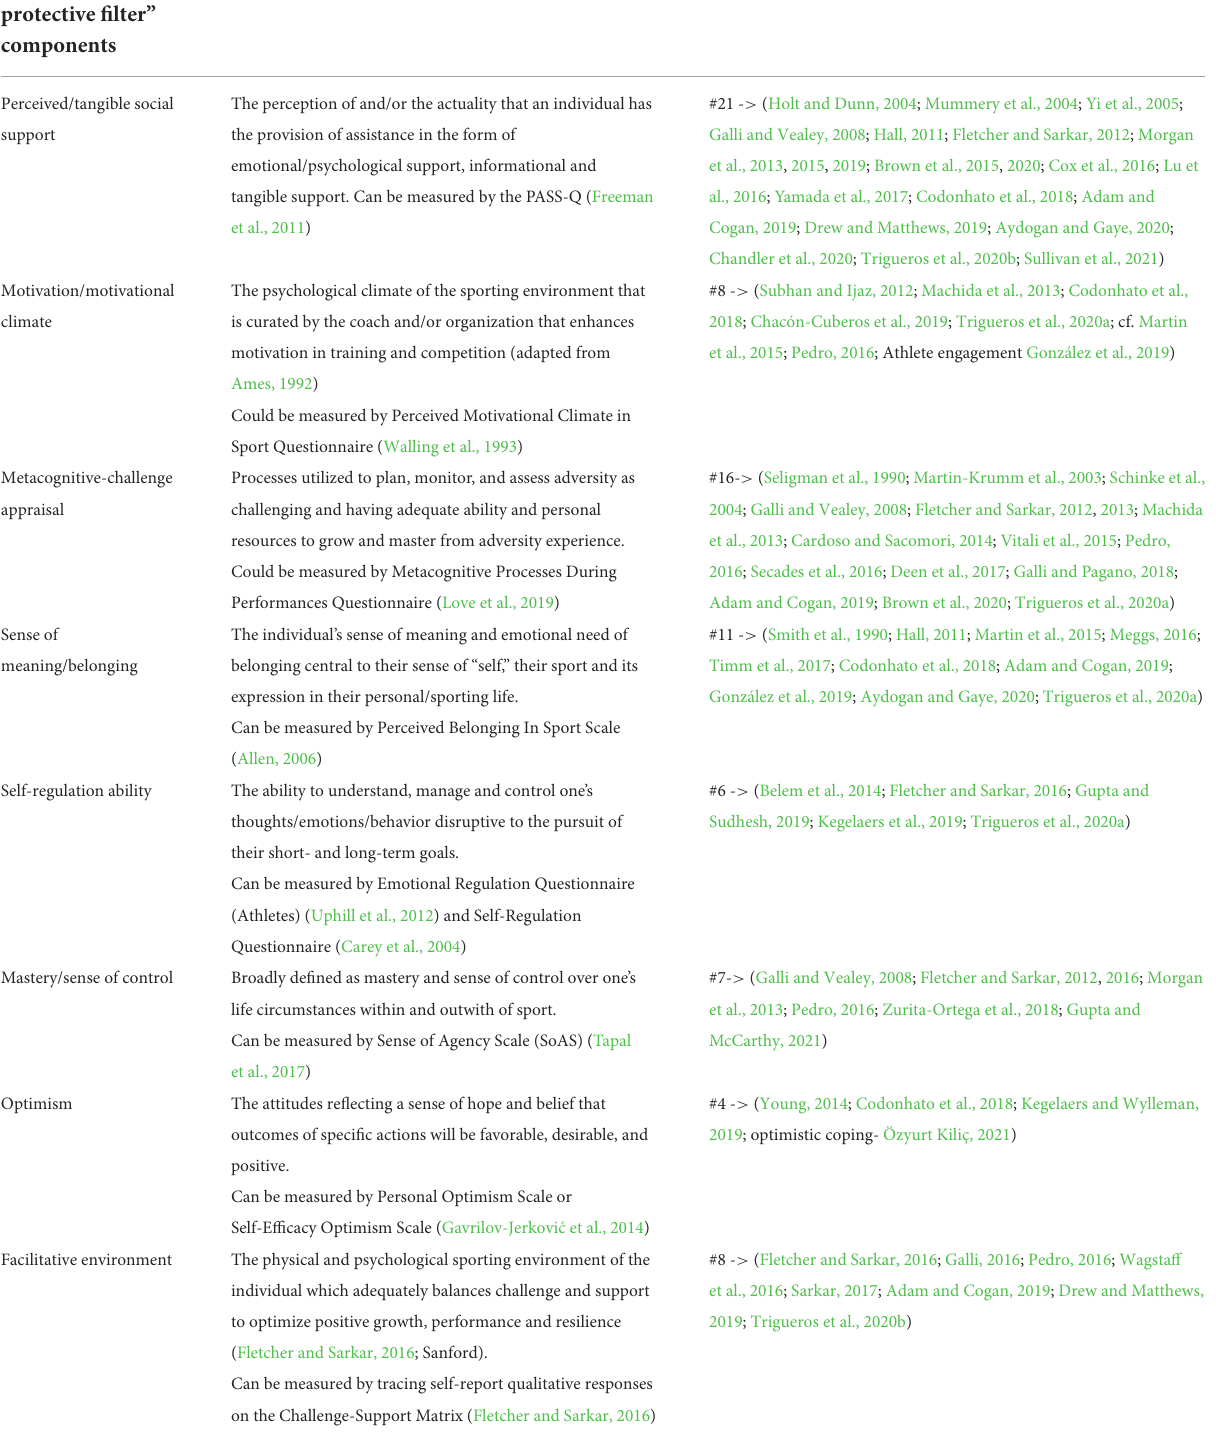
TABLE 2 Definitional clarity and empirical evidence of components of “biopsychosocial protective filter” of sporting resilience.